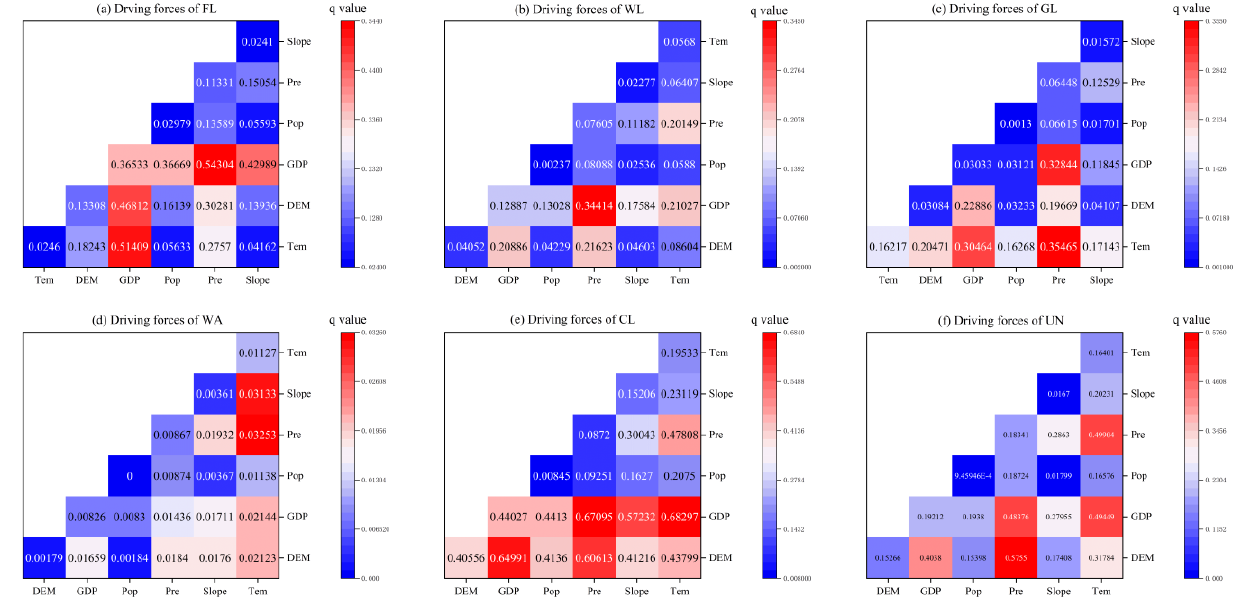
Figure 11. Interaction factors of ( a ) FL, ( b ) WL, ( c ) GL, ( d ) WA, ( e ) CL, and ( f ) UN. For farmlands, the explanatory power of the interactions between GDP and DEM, GDP and temperature were 0.51 and 0.46, respectively, indicating that the three factors, i.e., GDP, DEM, and temperature, jointly promoted the flow of farmlands during this period. For woodlands, the strongest explanatory power of the interaction between GDP and precipitation (0.34) indicates that GDP and precipitation were important factors in the transformation of woodlands. For grasslands, the interaction between temperature and precipitation had the greatest explanatory power (0.35), and the interaction between GDP and precipitation and GDP and temperature had explanatory powers of 0.32 and 0.30, respectively, reflecting the direct influence of precipitation and temperature on